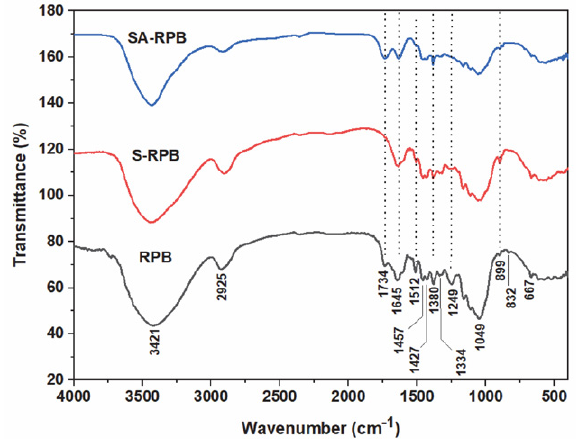
Fig. 2. FTIR spectra of RPB, S-RPB and SA-RPB samples